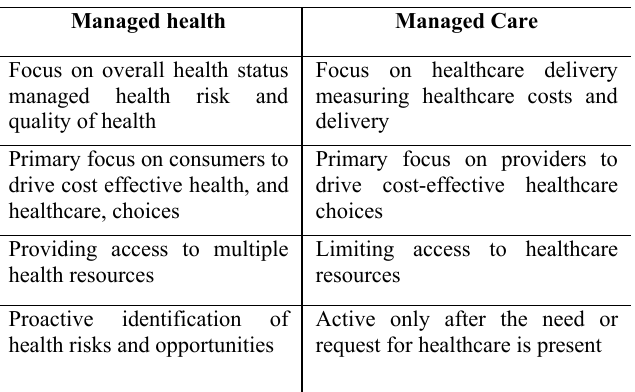
Table 1: Managed health versus managed